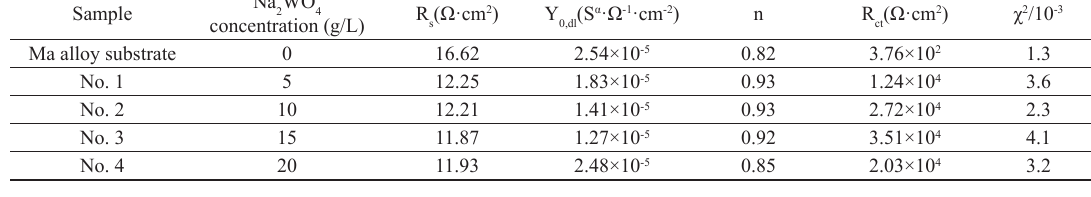
Table 6. Electrochemical parameters from EIS data of magnesium alloy and Ni-W-P coatings with different Na 3.5 wt.% NaCl solution.